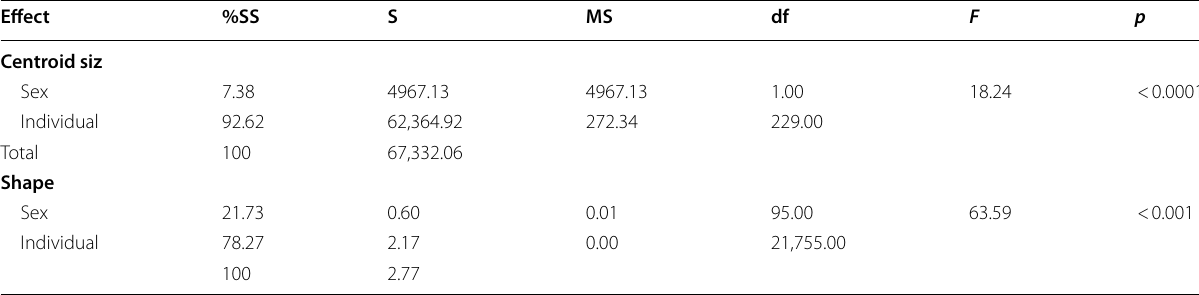
Table 3 Procrustes ANOVA of centroid size and shape